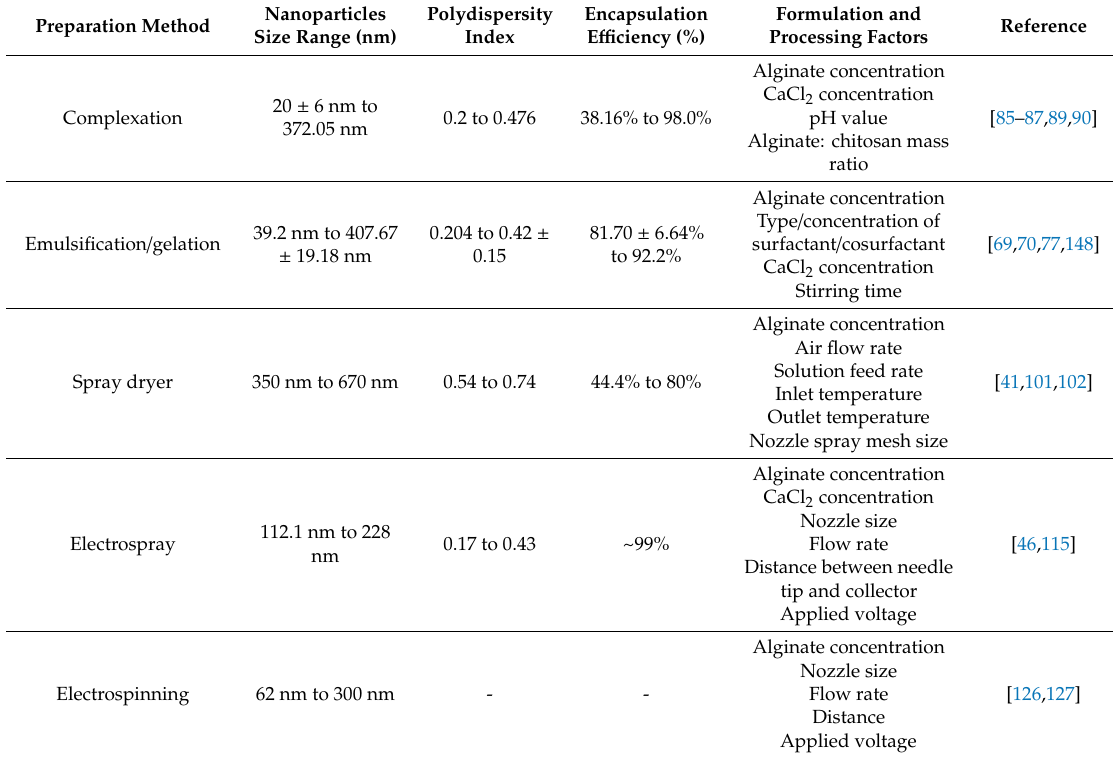
Table 8. Summary of characterization and formulation / processing factors that influence the formation and properties of alginate